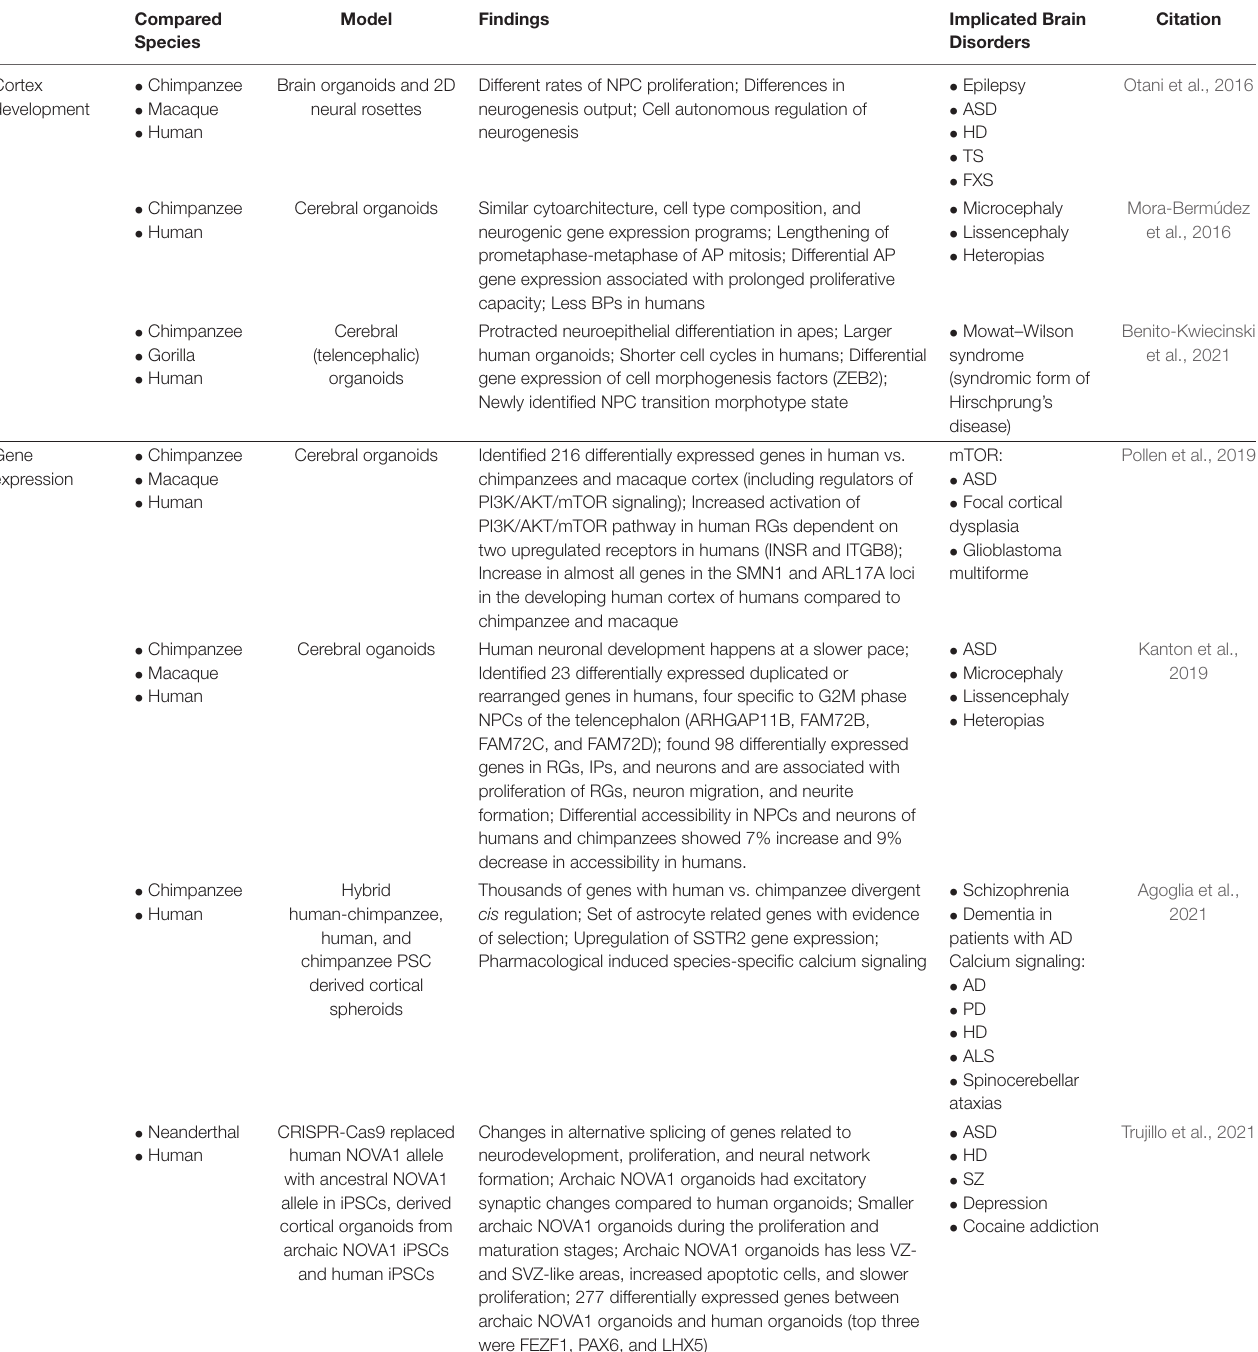
TABLE 2 | Overview of primary literature employing human, NHP, and ancestral gene edited brain organoids to elucidate human-specific processes of brain development and implicated brain disorders. Compared